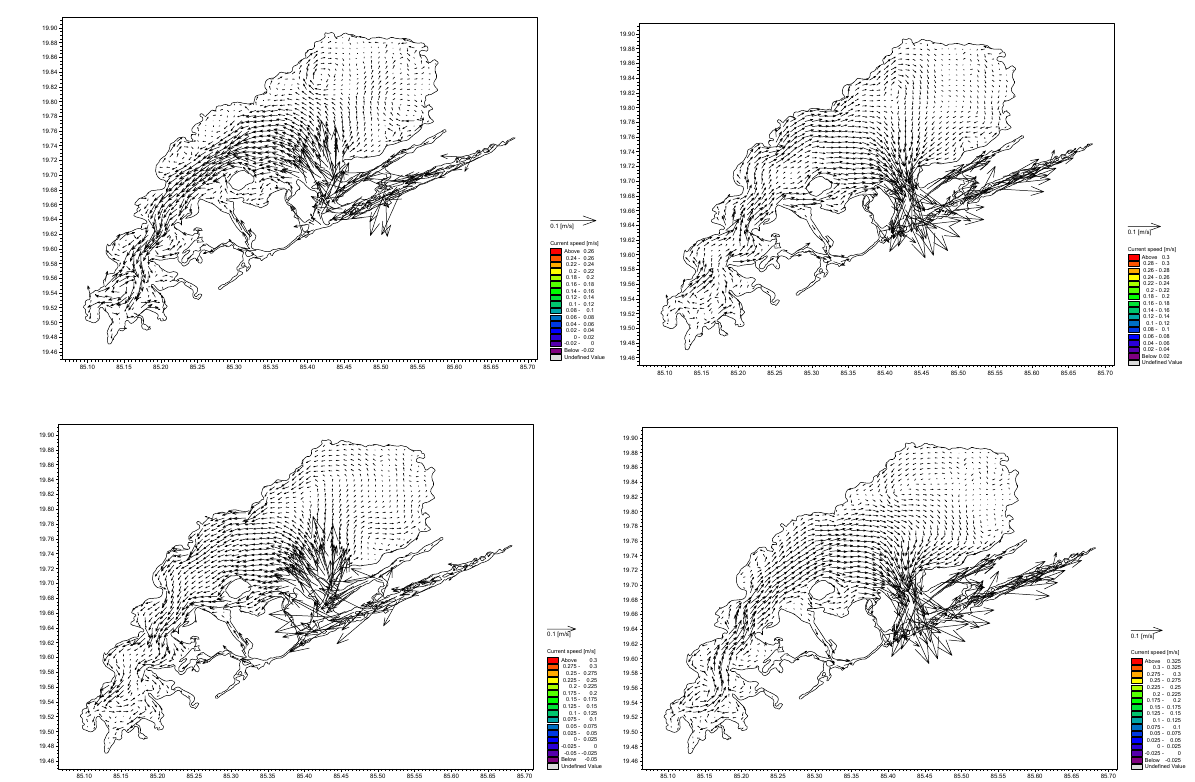
Figure 6. Simulated surface water current during a) Flood (May 2009), b) Ebb (May 2009), c) Flood (December 2009) and d)